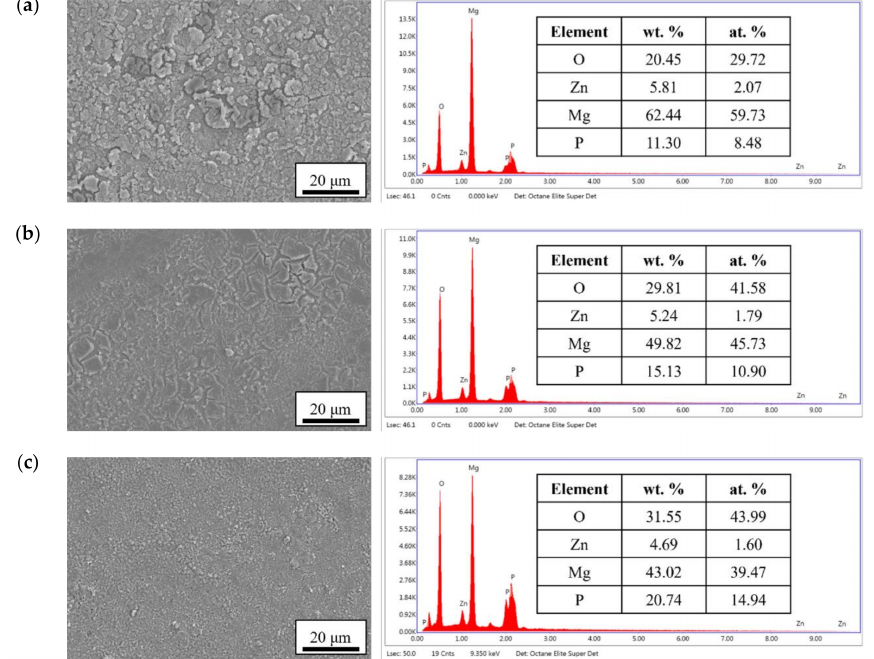
Figure 1. Surface morphologies and EDS spectra of the anodic coatings prepared at ( a ) 50 V, ( b ) 150 V, and ( c ) 250 V for 10 min.